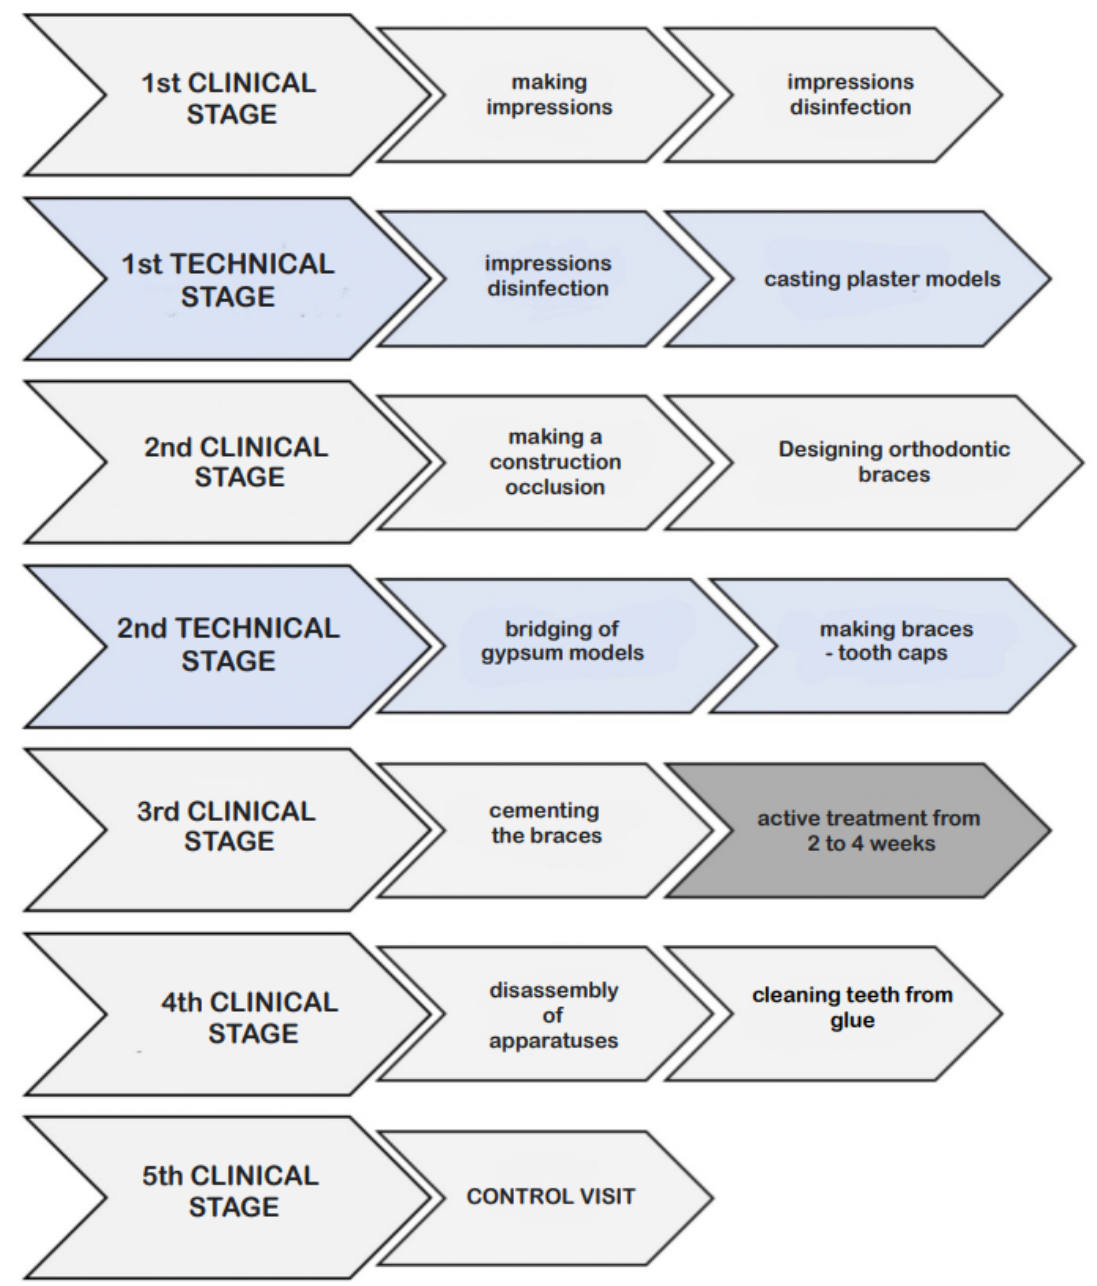
Figure 14. Protocol of the procedure.